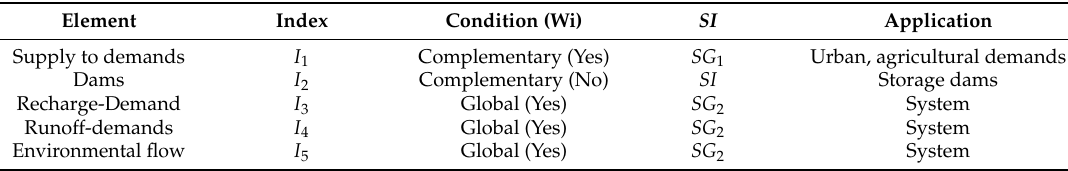
Table 1. Summary of indexes and their